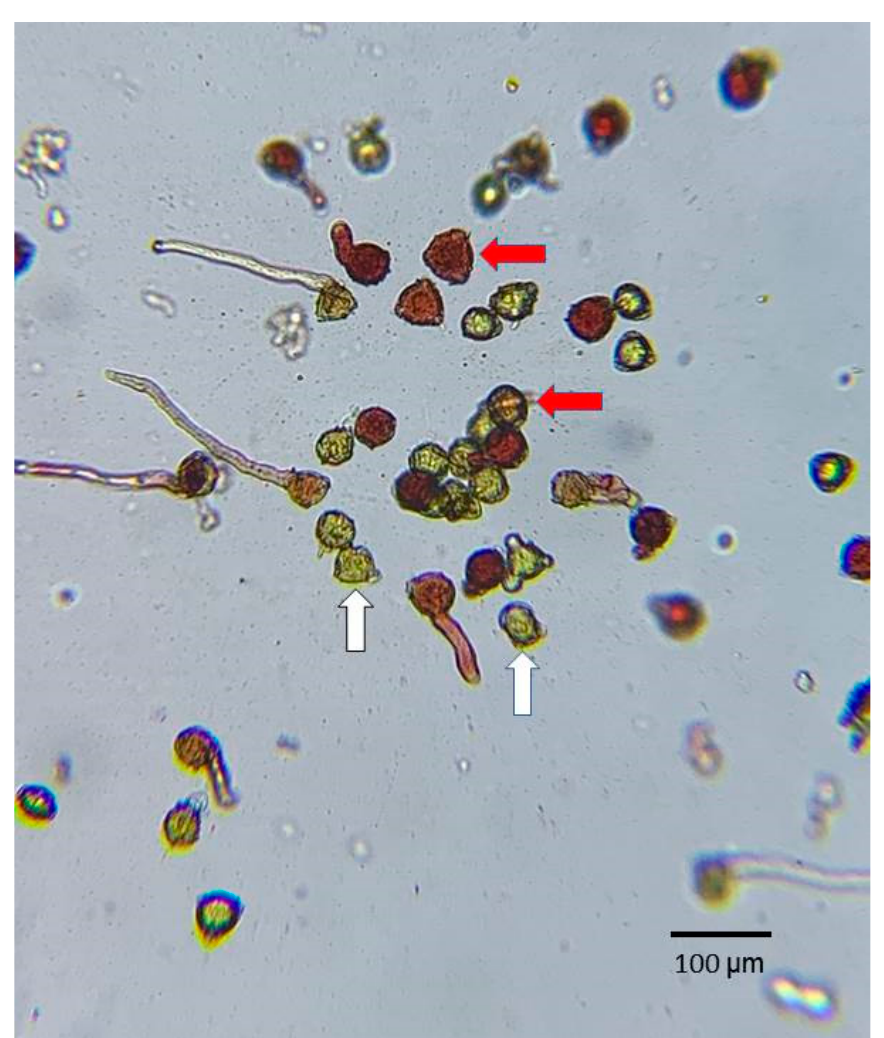
Figure 2. TTC (2,3,5-triphenyl tetrazolium chloride) staining test of tea pollen. Pollen grains that turned red or pink (indicated by red arrows) were considered viable. Pollen grains lacking red color (indicated by white arrows) were classified as inactive. Magnification, 100×.